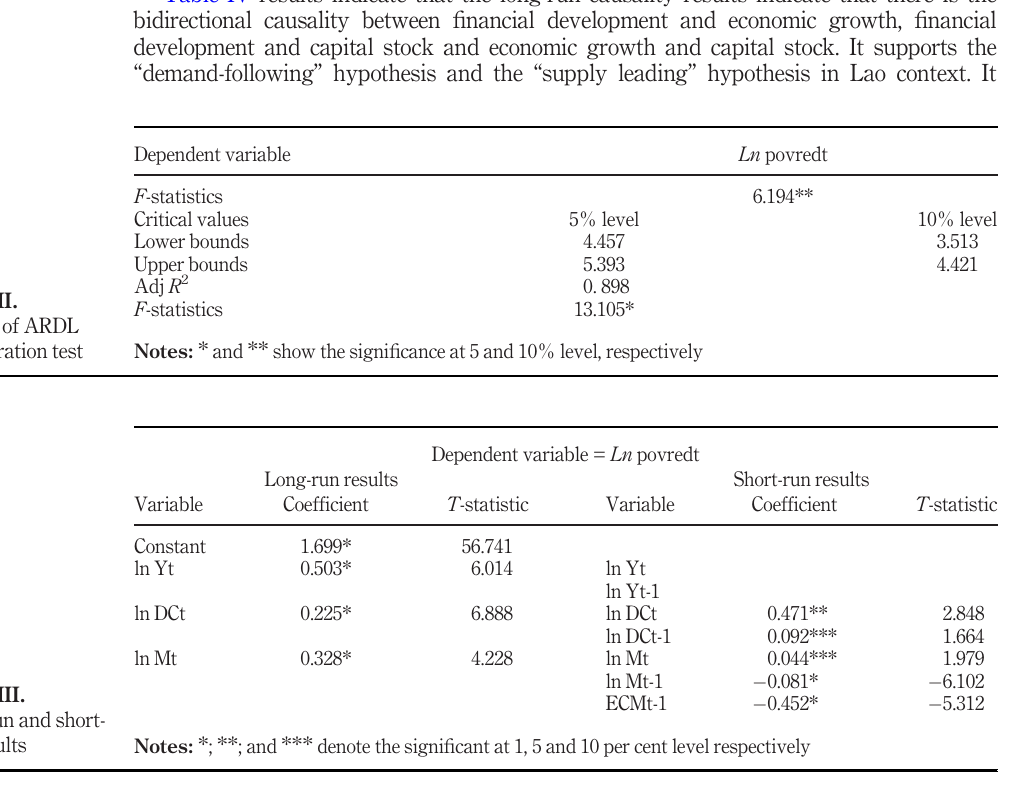
Table III. Long-run and short- run results